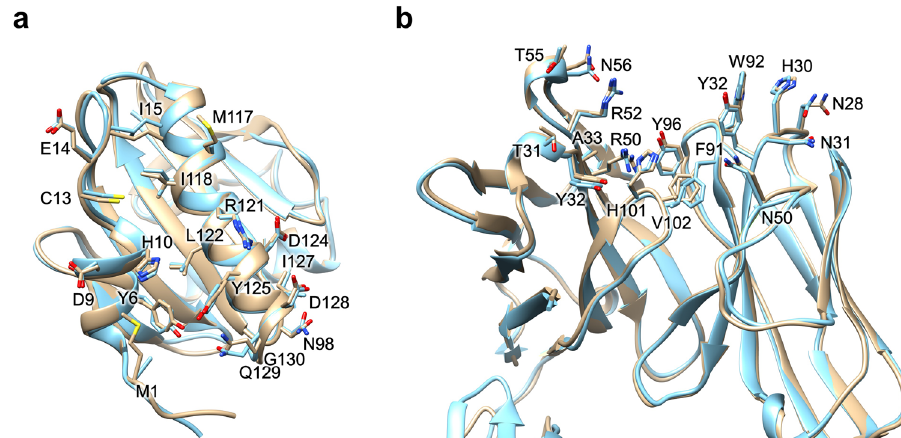
Fig. 4 Paratope-epitope interactions. a Epitope residues. Structural alignment of the Fab/IgE-rHev b 8 models at 3.04 Å (gold) and 3.34 Å (blue). b Paratope residues alignment of the models at 3.04 Å (gold) and 3.34 Å